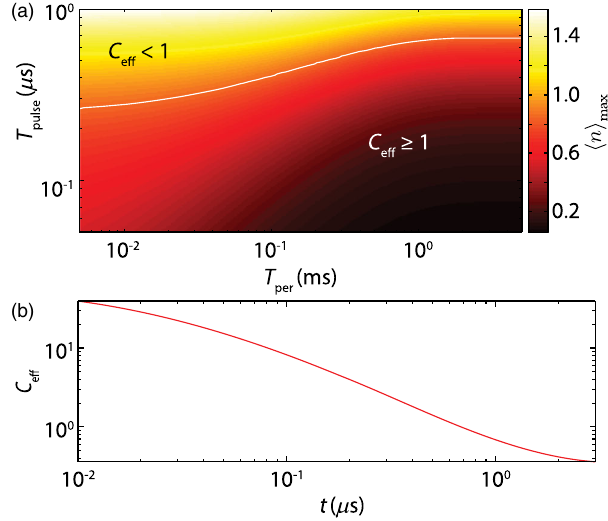
FIG. 4. (a) Maximum phonon occupancy during a pulse h n i max versus pulse period T and pulse width T . The white contour per pulse ≥ 1 delineates the region where the effective cooperativity C eff throughout the pulse. (b) C versus time t within the pulse for eff ¼ 5 ms and T ¼ 3 μ T per pulse